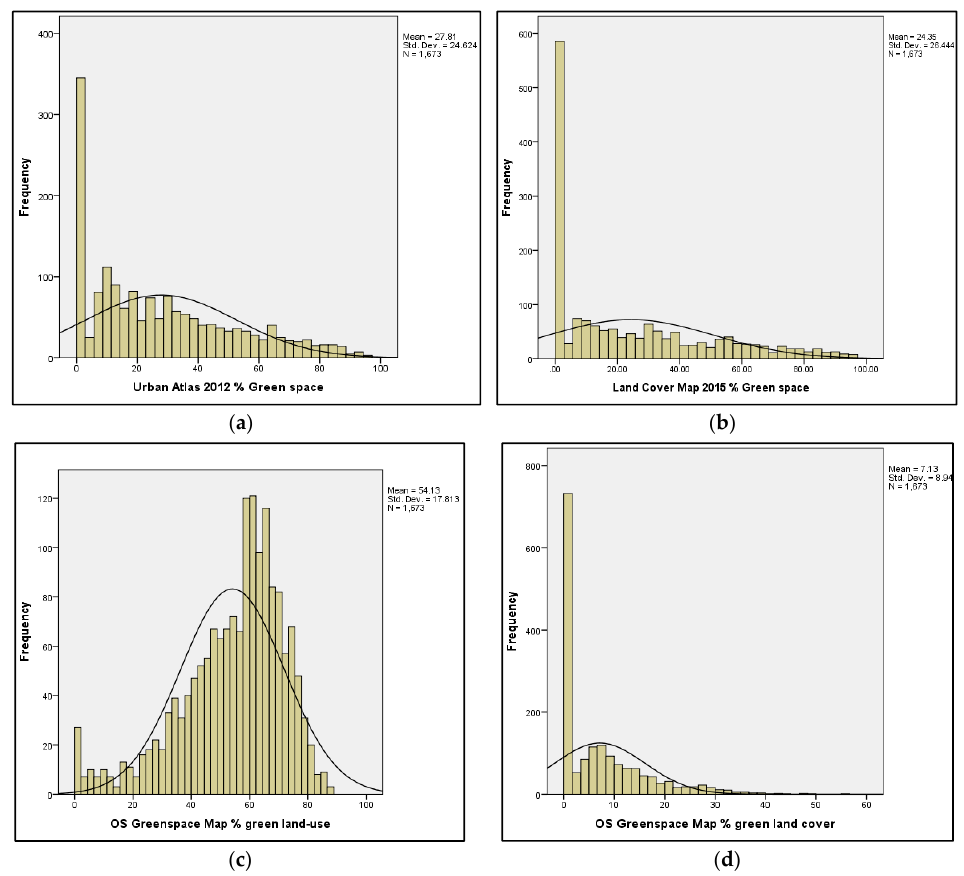
Figure 5. Frequency distribution of green space cover in local urban neighbourhoods. Top left, ( a ): Urban Atlas (EEA, 2012); Top right ( b ): Land Cover Map (Rowland et al. 2017); Bottom left ( c ): OS Mastermap Greenspace Layer, land use (Ordnance Survey, 2017); Bottom right, ( d ): OS Mastermap Greenspace Layer, land cover (Ordnance Survey, 2017).